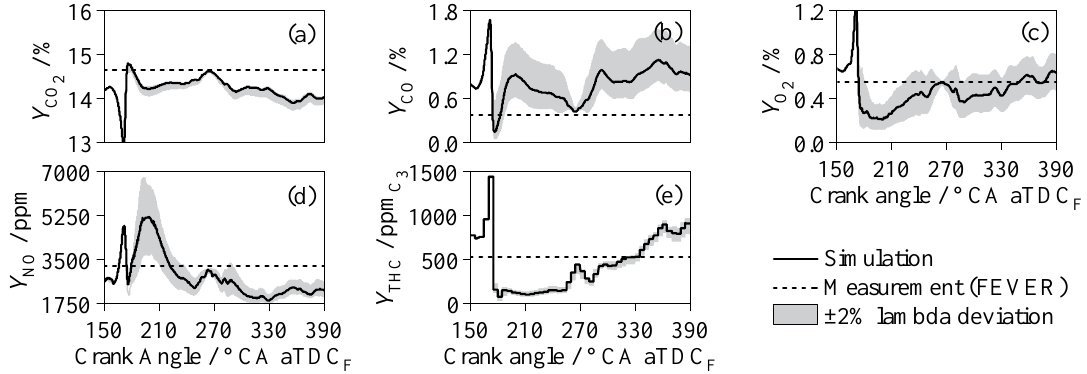
Figure 10. Effect of ± 2% λ on simulated emissions concentrations in Pos. 2 compared with measurements (FEVER): ( a ) CO 2 , ( b ) CO, ( c ) O 2 , ( d ) NO, and ( e ) THC. Operating point